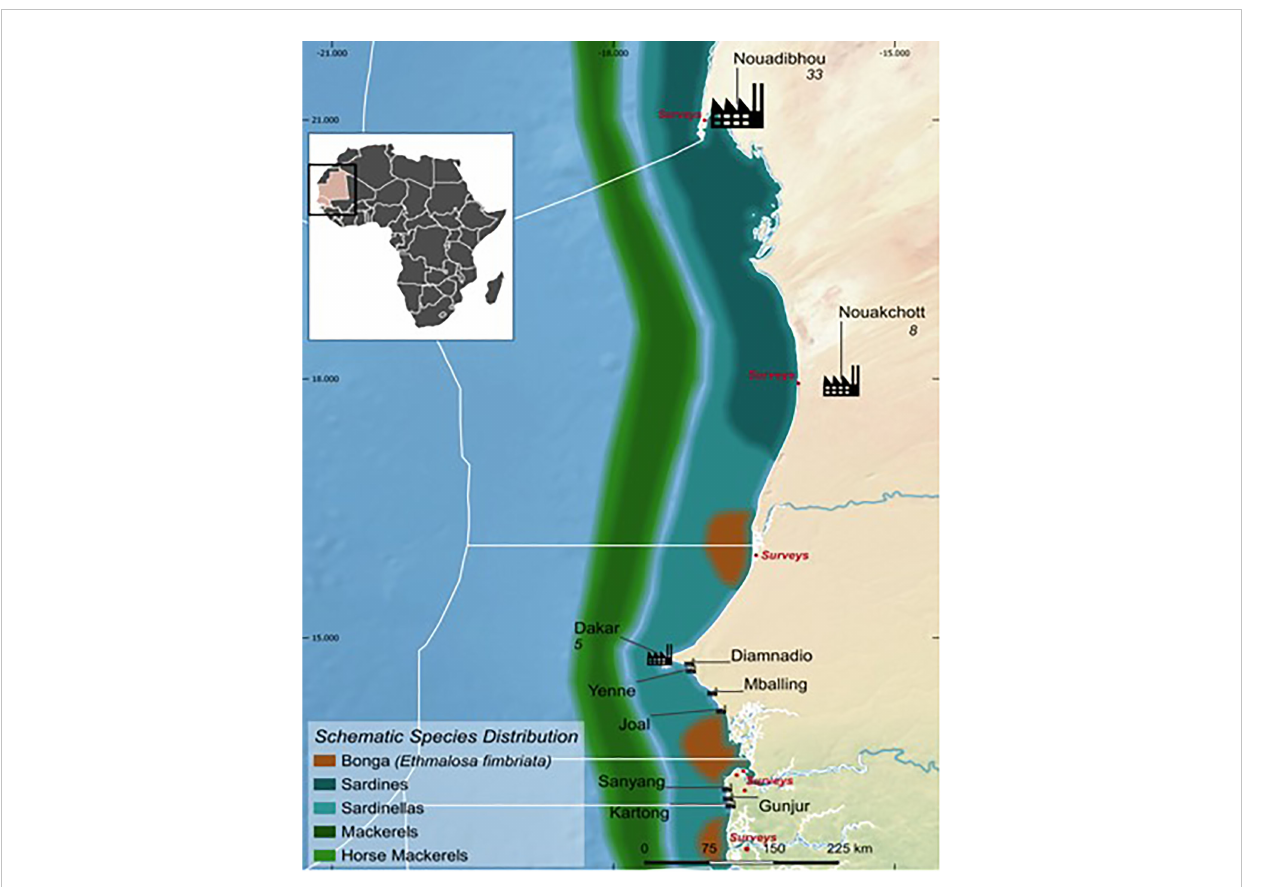
FIGURE 1 Distribution of small pelagics species and location of fi shmeal factories in Senegal, Gambia and Mauritania 5 . (This distribution of small pelagics in Senegal, Mauritania and The Gambia has been done considering the opinion of the fi shermen and the scienti fi c literature). Source: Field